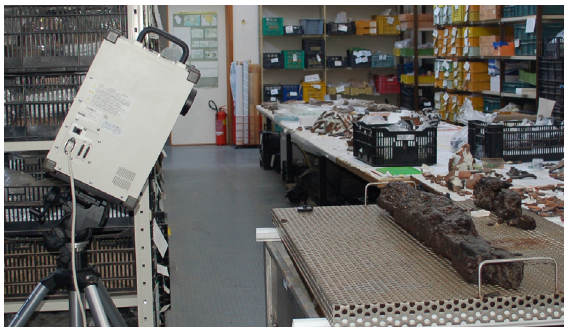
Figure 3. A Minolta ® Vivid 900 was used for the first experiment on a large wooden fragment.